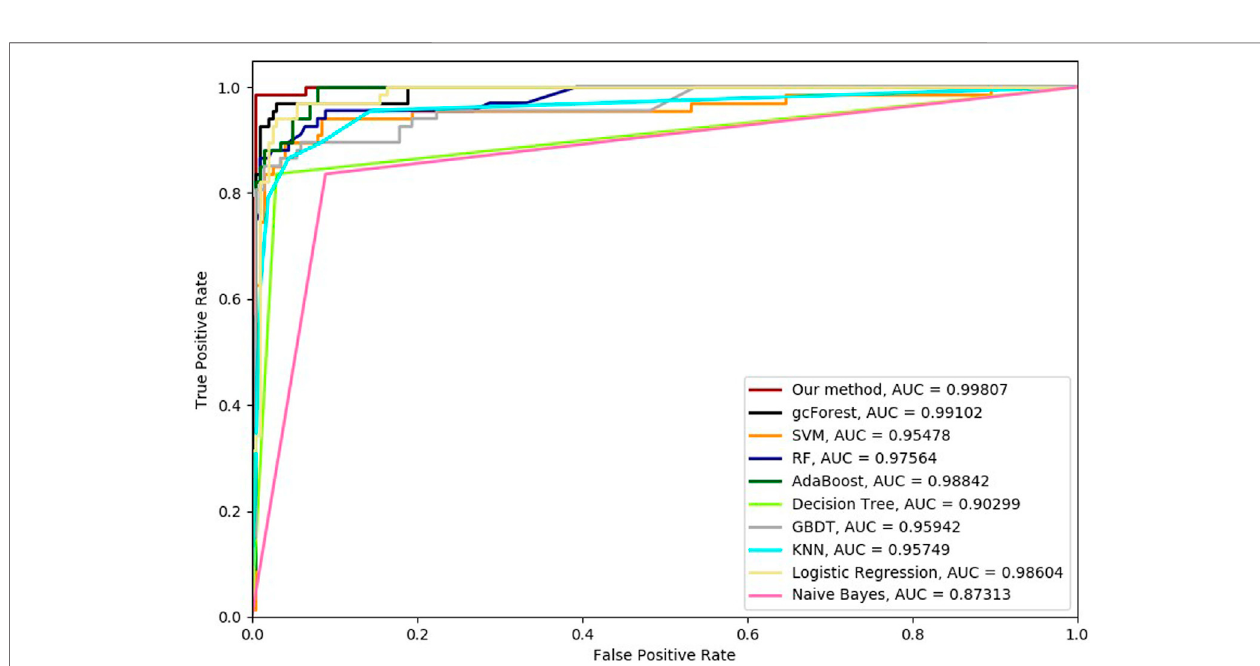
Frontiers in Genetics |